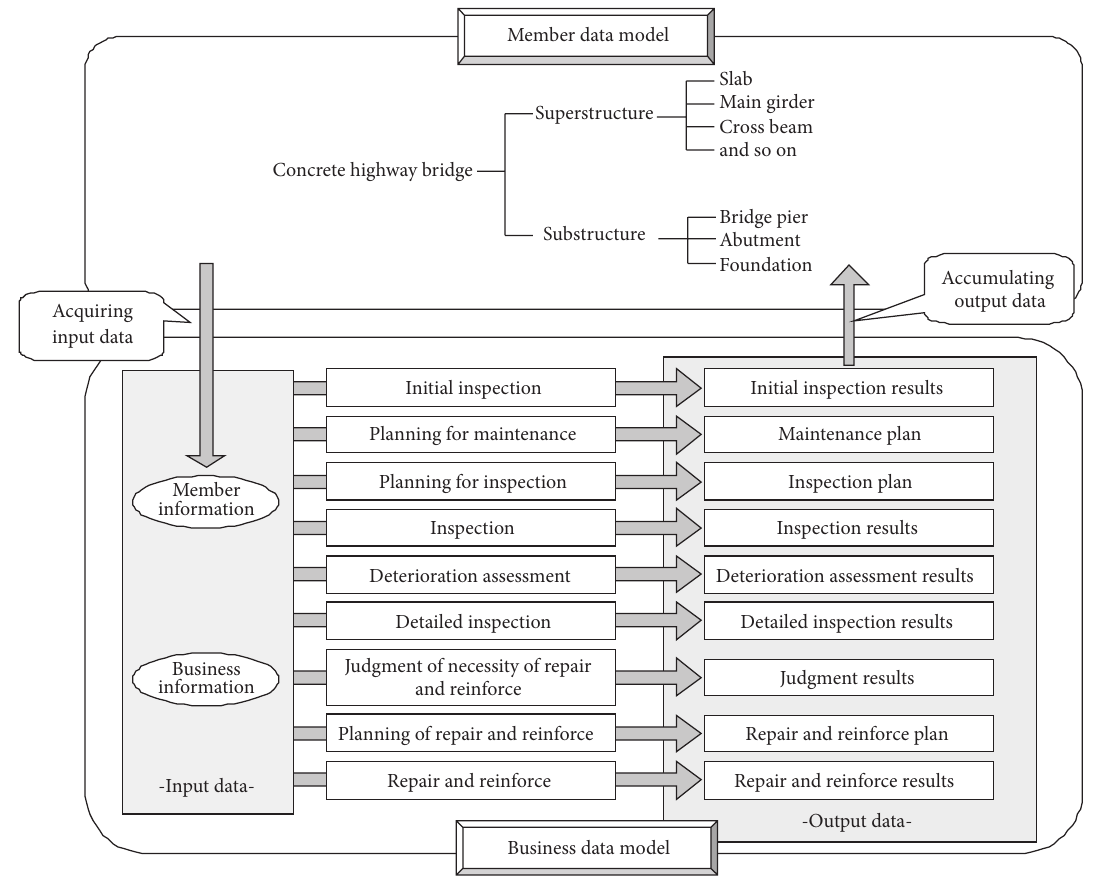
Figure 3: Relation between product data